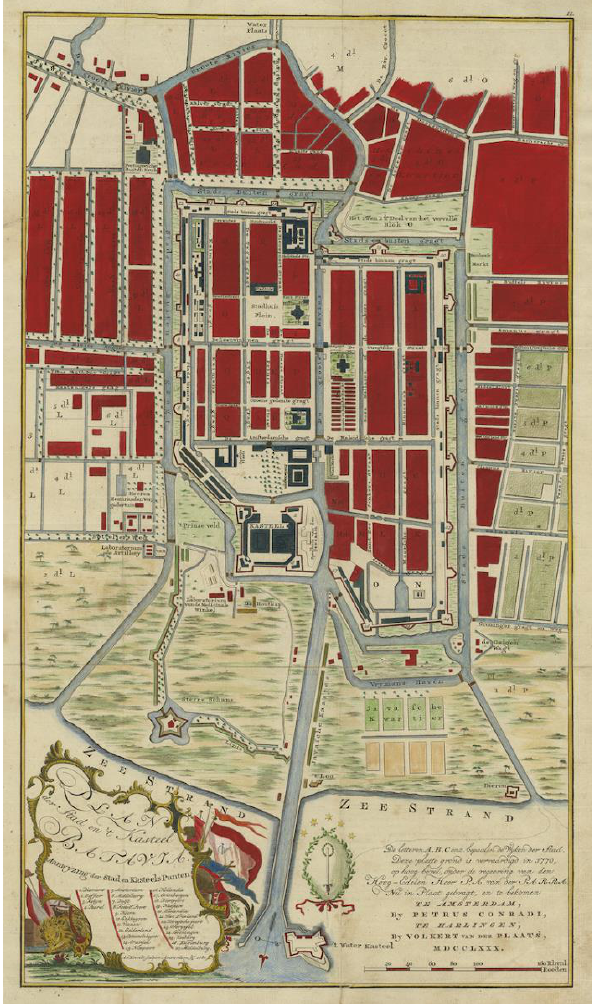
Figure 16. The castle of Batavia, at the mouth of the Ciliwung River. The map shows the outline of the city of Batavia and its defensive walls and bastions in 1780. Visible in the bottom is the Waterkasteel. A.